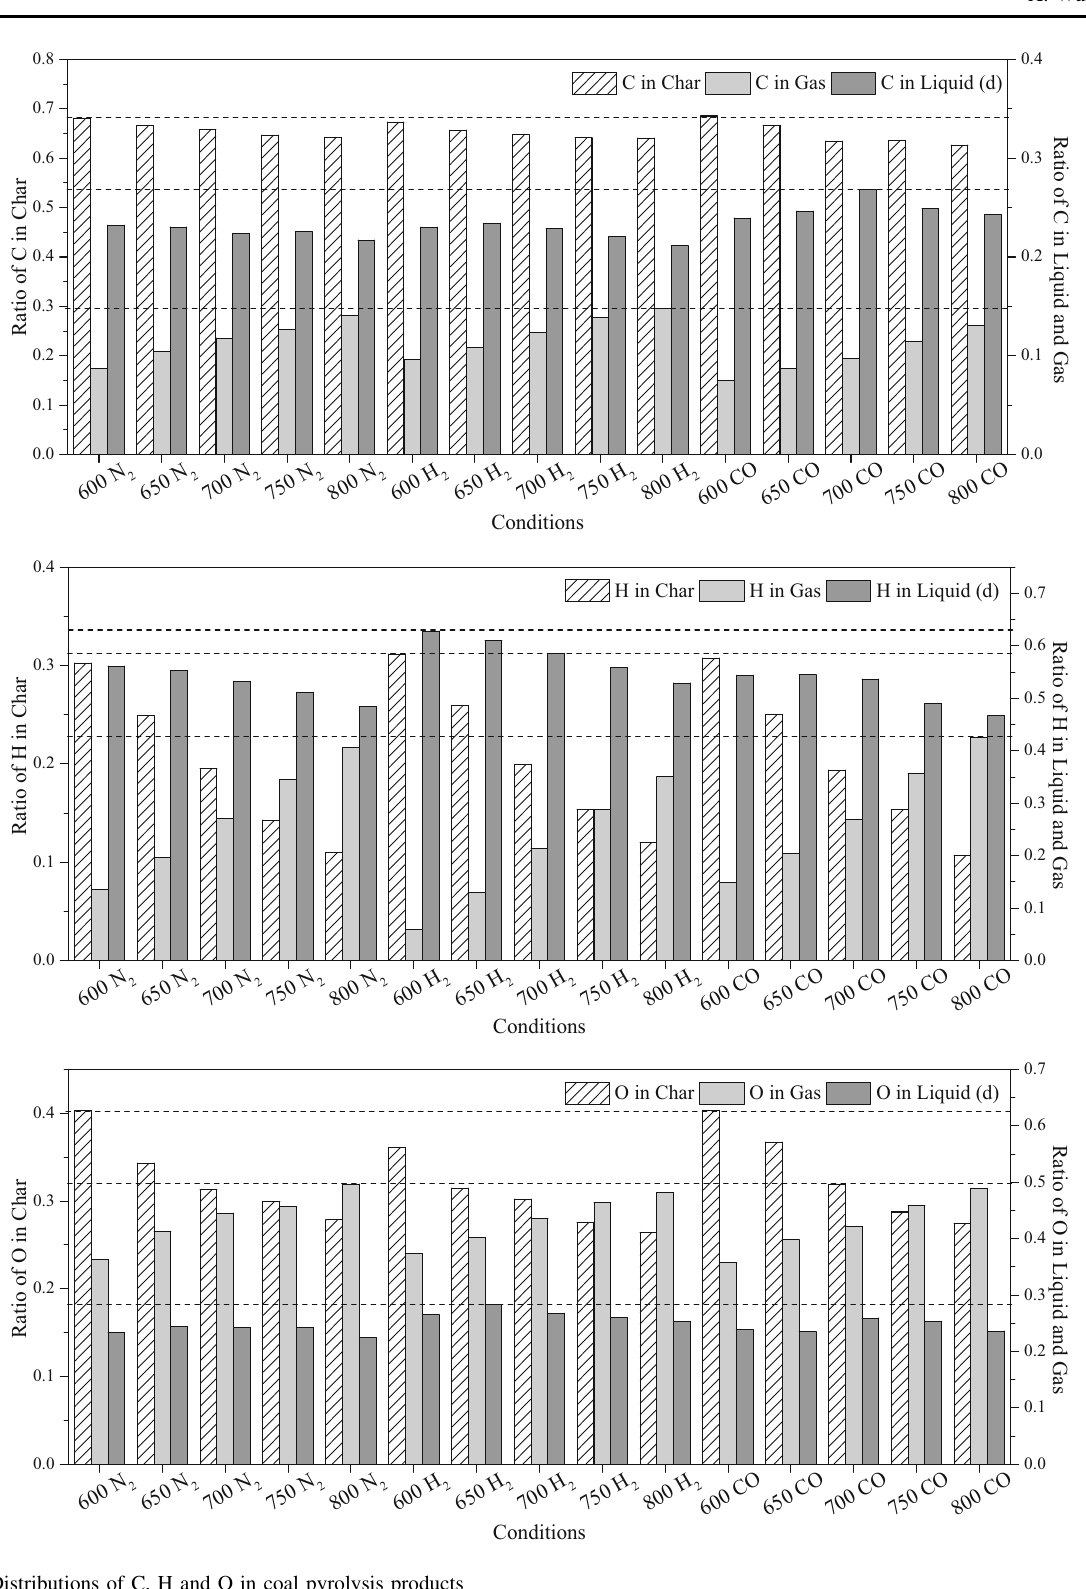
Fig. 5 Distributions of C, H and O in coal pyrolysis to the increase of H in liquid as show in the Fig. 5. The maximum value of H distribution in the liquid was 62.9%